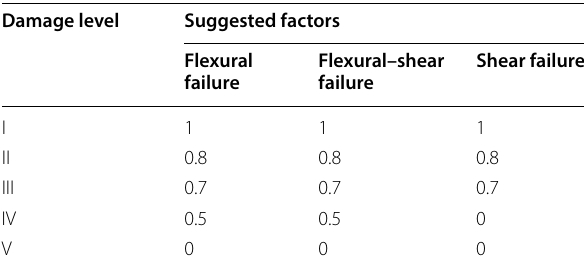
Table 11 Suggested reduction factors of stiffness for RC column